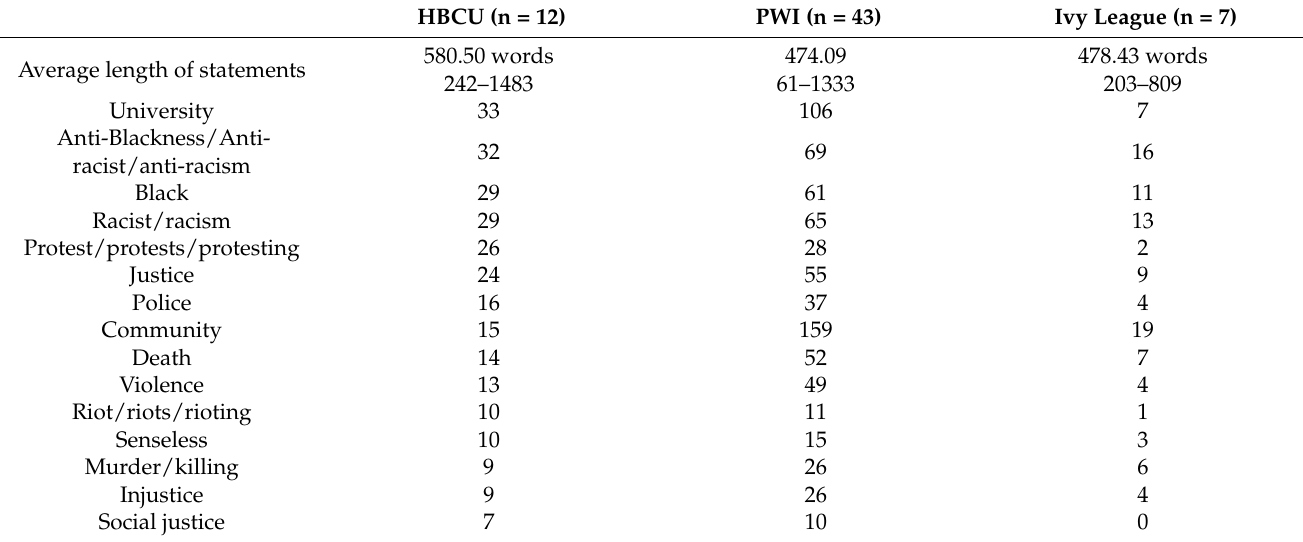
Table 1. Most frequently occurring themes by university